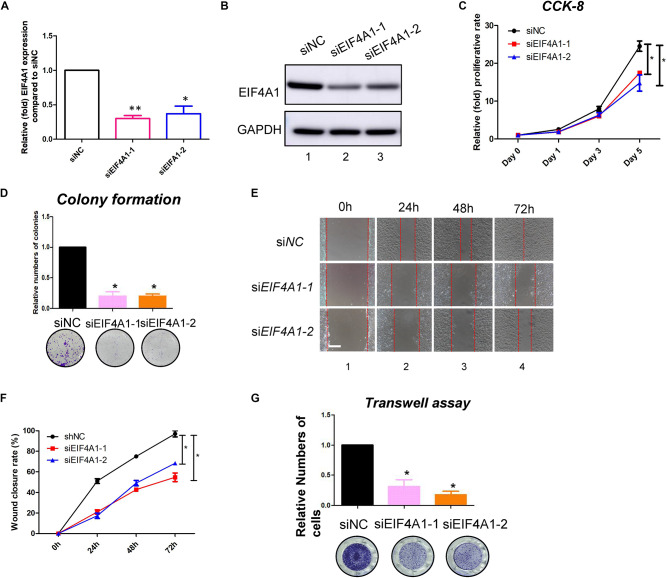
EIF4A1 promoted the cell growth and migration in keratinocytes. (A) Real-time PCR was performed to measure the EIF4A1 mRNA expression in the EIF4A1-silenced HaCaT cells. Scramble-siRNAs served as a negative control (siNC). *p < 0.05, **p < 0.01. (B) A western blot assay was performed to identify the EIF4A1 protein expression in the EIF4A1-silenced HaCaT cells. GAPDH was referred as endogenous control. (C) A CCK-8 assay was performed to determine the proliferative rate of the EIF4A1-silenced cells. The OD value of Day 0 was set as 100%. *p < 0.05. (D) A colony formation assay was performed to determine the colony formation ability of the EIF4A1-silenced cells. The colony number in the shNC group was set as 100%. All experiments were performed in triplicate, and the relative colony formation rates are shown as the mean ± SEM. *p < 0.05. (E) A wound healing assay was performed to determine the migratory ability of the EIF4A1-silenced keratinocytes (HaCaT). Scale bar: 50 μm. (F) Quantification of the wound recovery rate in the wound healing assay. All experiments were performed in triplicate, and the relative cell migration ratio is shown as the mean ± SEM. *p < 0.05. (G) A transwell assay was performed to determine the migratory ability of the EIF4A1-silenced cells. Quantification of the numbers of transferred cells is shown in the upper panel. The colony number in the empty vector group was set as 100%. All experiments were performed in triplicate, and the relative cell numbers are shown as the mean ± SEM. *p < 0.05.